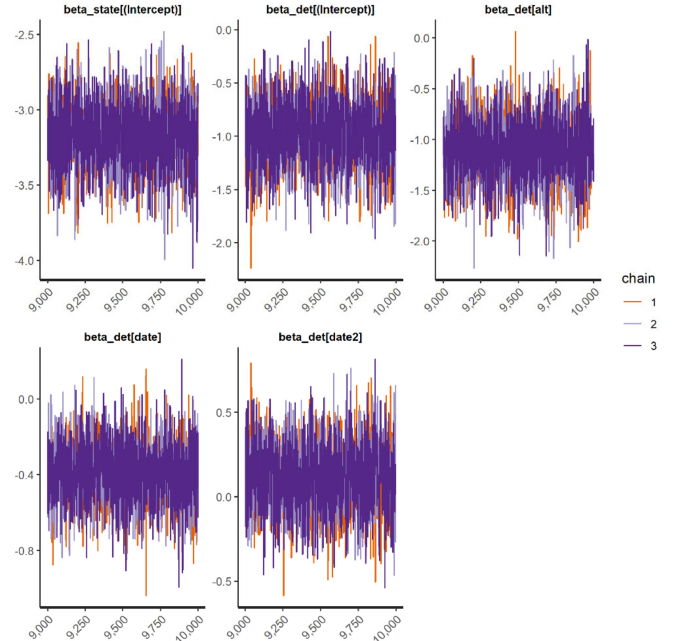
Figure A14. Traceplots from the best occupancy model of cane toad ( Rhinella marina ) in Puerto Rico: ( ψ (intercept); ρ (intercept + elevation + date + date2)). Note: alt = elevation; date = Julian date (we considered Julian day 1 as the first day of a device starting to record in the field, which was 1 March 2021); date2 = square of Julian